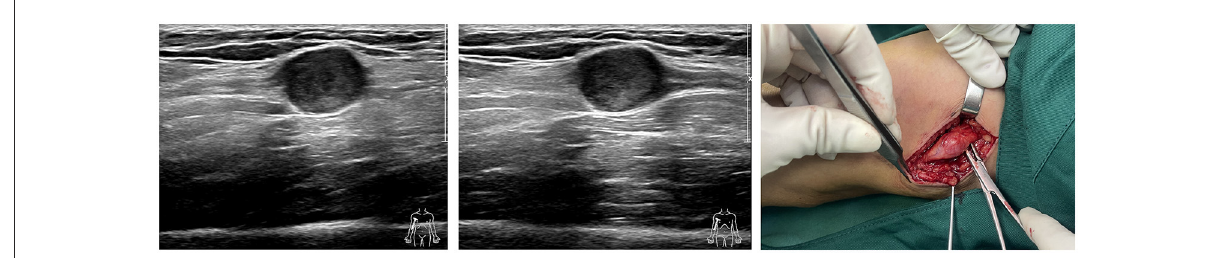
FIGURE6 Ultrasound images and intraoperative images of schwannomas of ulnar nerve origin in the upper